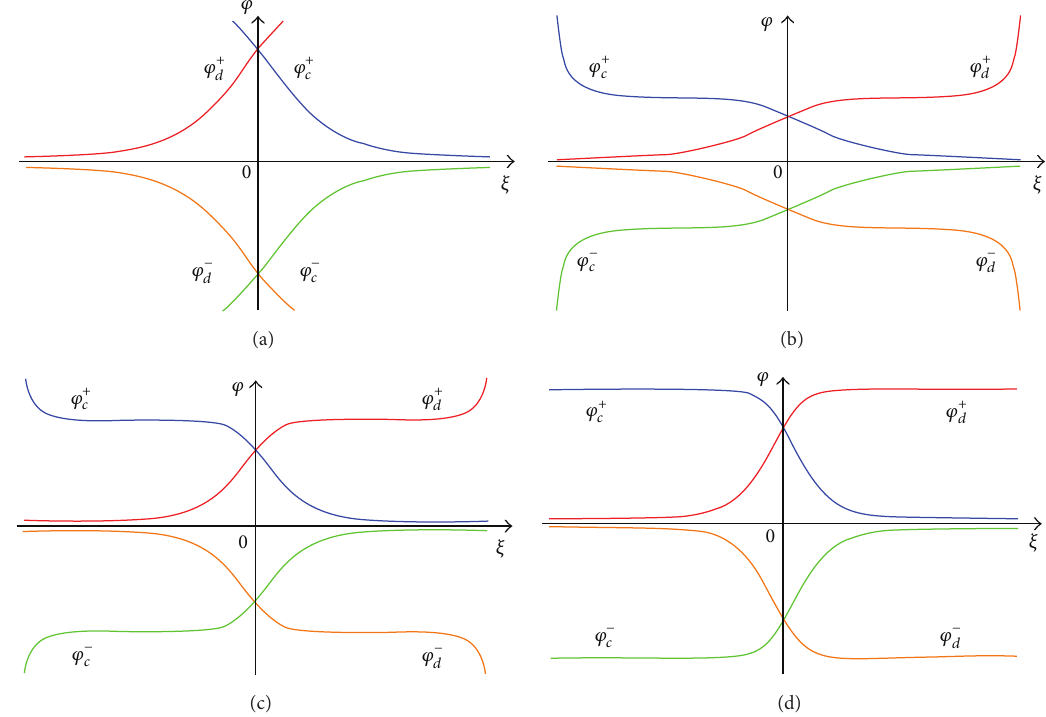
Figure 7: (The four low-kink waves are bifurcated from four 1-blow-up waves.) The varying process for the figures of 𝜑 ± 𝑐 and 𝜑 ± 𝑑 when (𝑞,𝑝) ∈ 𝐴 , 𝜆 > 0, 𝜆 ̸= √𝜆 /12 , and 𝑝 → 3𝑞 2 /16𝑟 + 0 , where 𝑟 = 1 , 𝑞 = −4, 𝜆 = 4, and 𝑙 4 0 𝑝 = 3 + 10